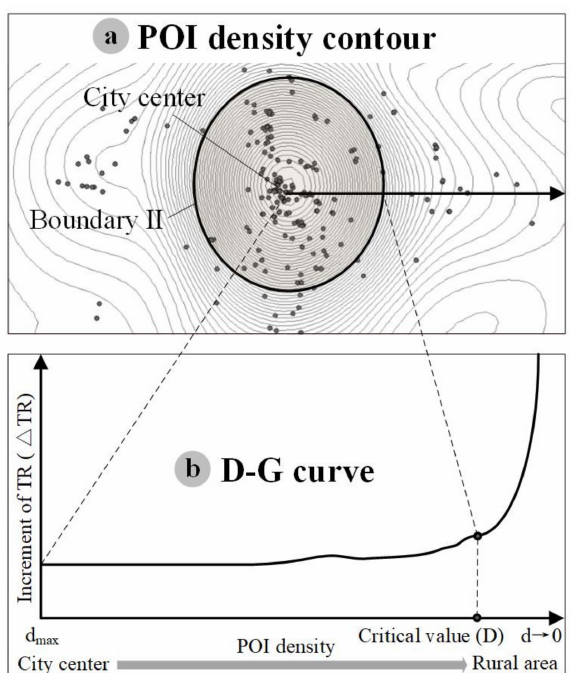
Figure 4. D-G Method. ( a ) POI density contour; ( b ) The D-G